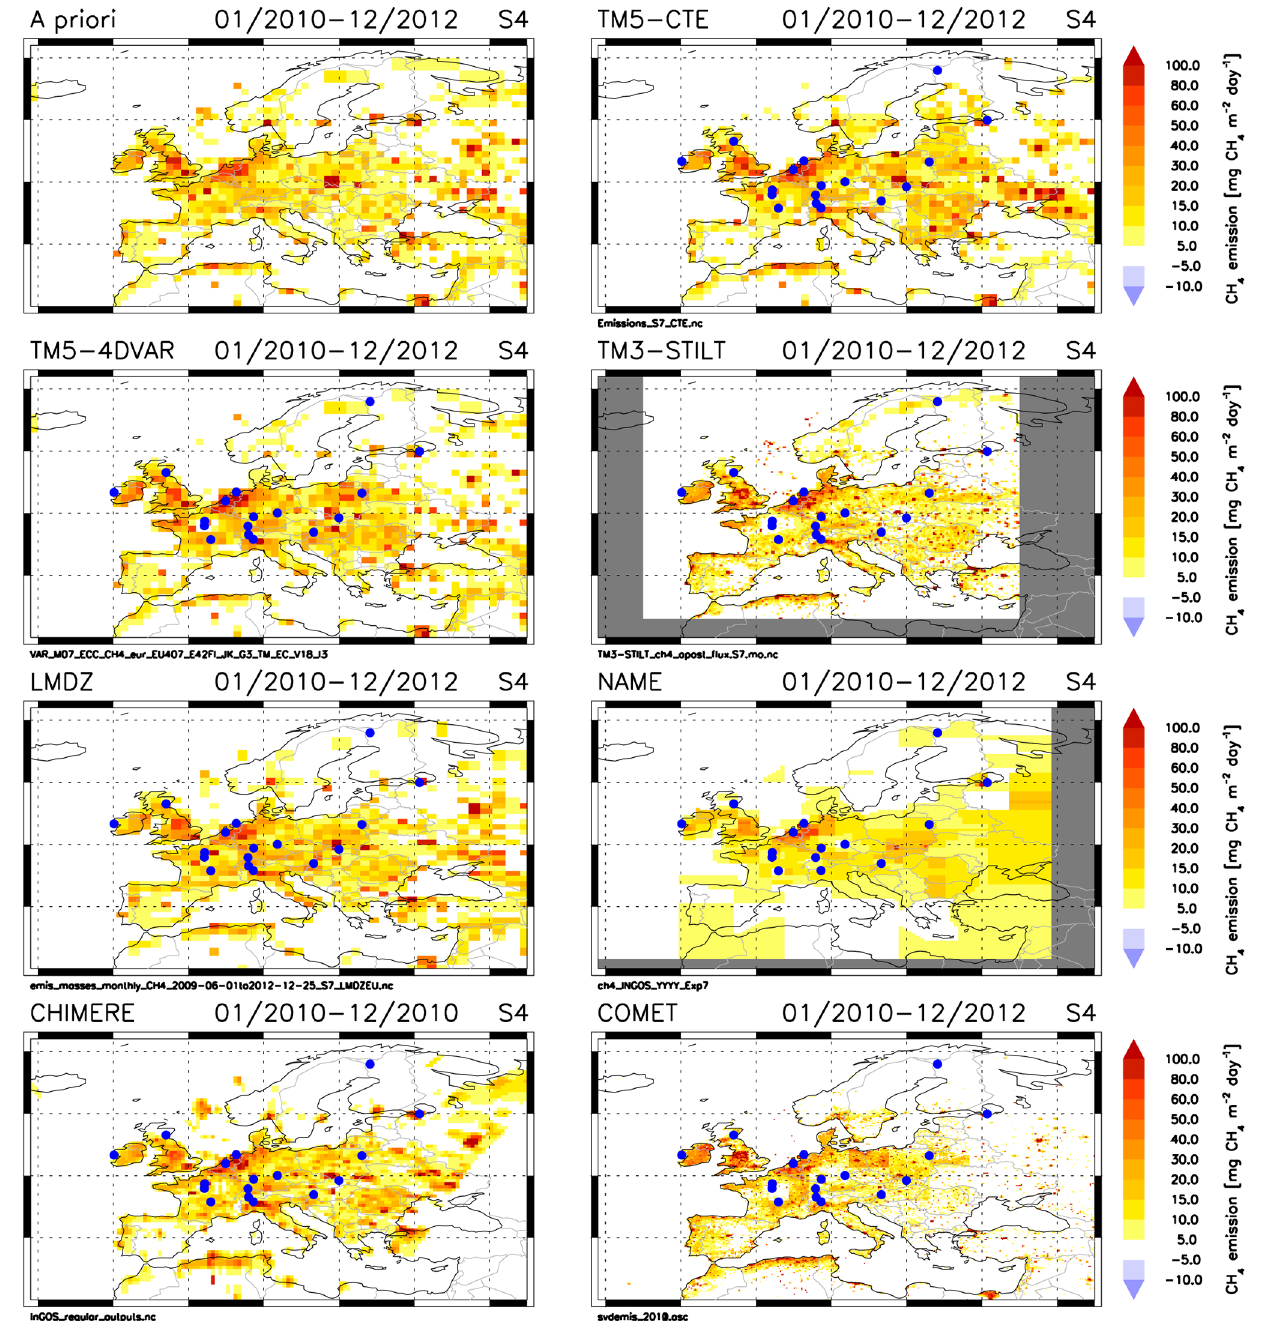
Figure 2. European CH 4 emissions derived from the seven inverse models (inversion S4; average 2010–2012; for CHIMERE only 2010). Filled blue circles are the locations of the InGOS measurement stations. Upper-left panel shows a priori CH 4 emissions (as applied in TM5-4DVAR at 1 ◦ × 1 ◦ resolution, while regional models use a higher resolution for the a priori emissions). Dates are